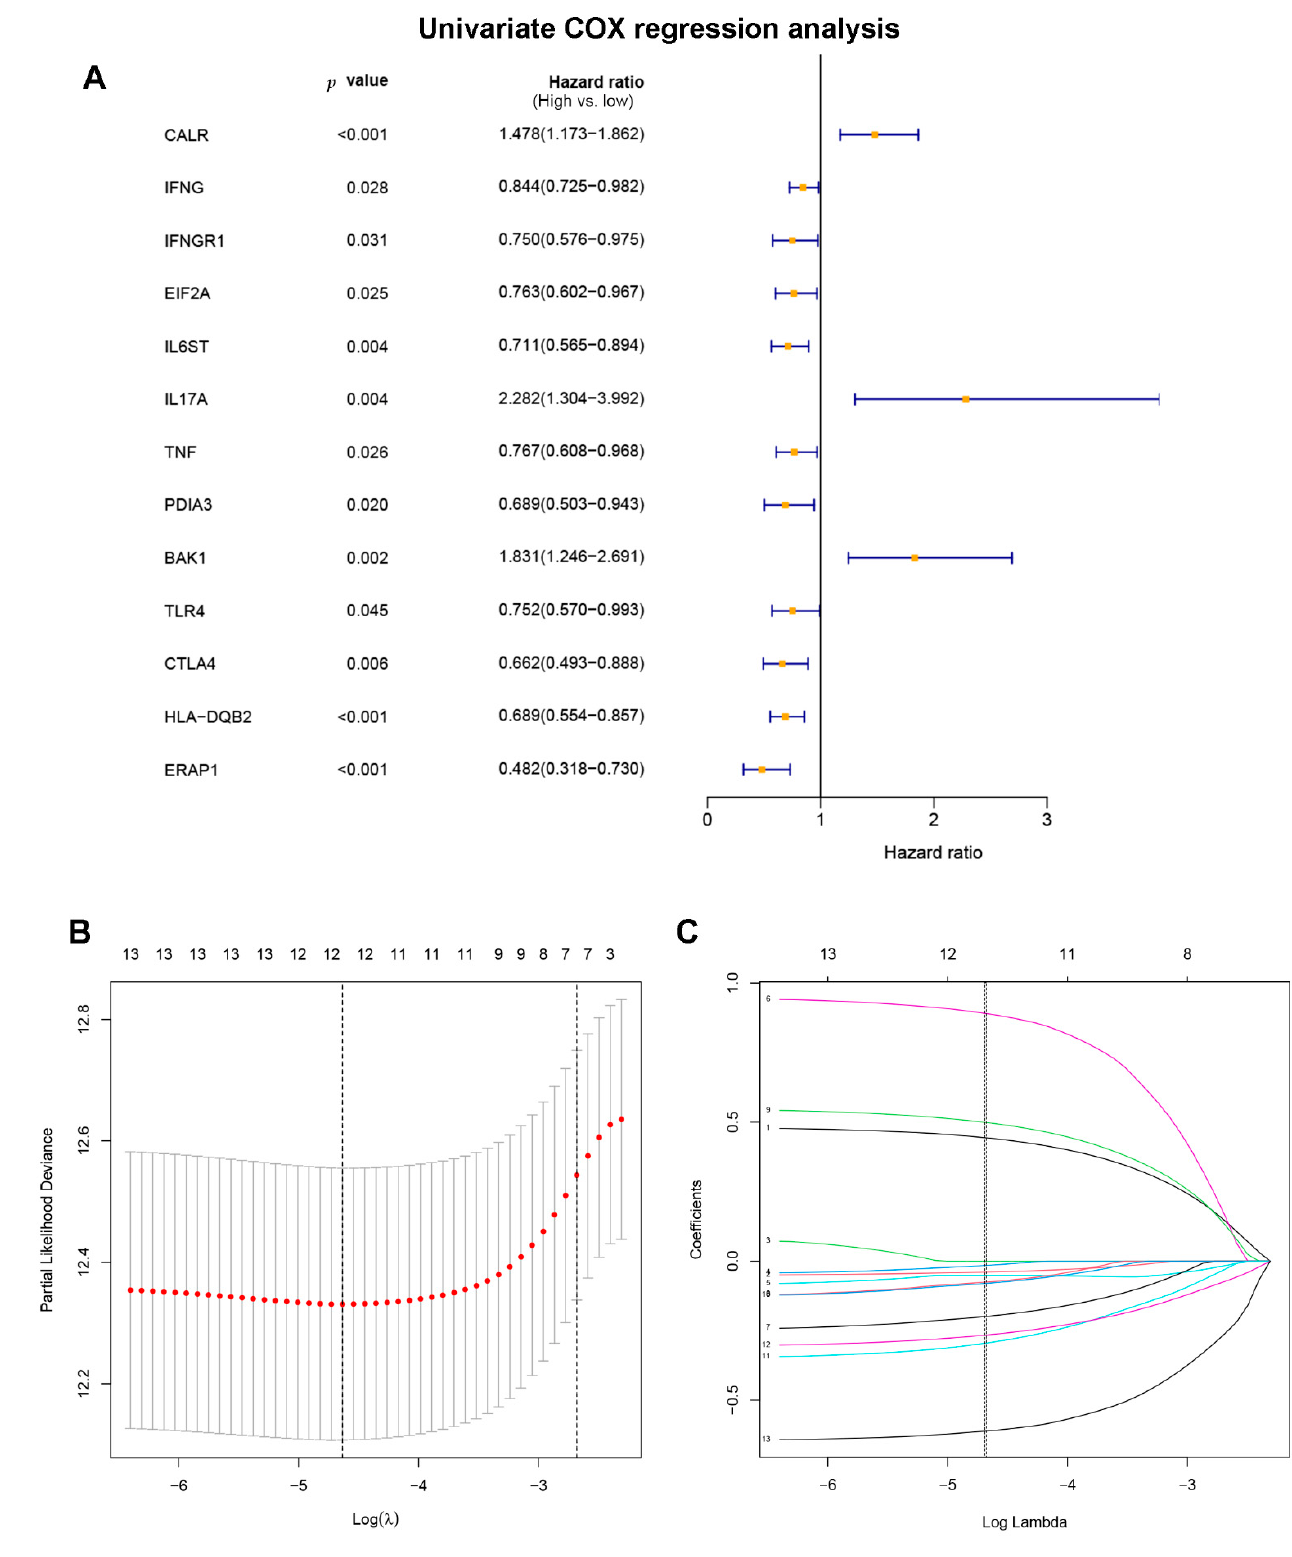
Figure 2. Construction of ICD-related gene signature. ( A ) Identify prognostic immunogenic cell death-related genes through univariate Cox regression analysis. ( B ) The optimal λ was selected, which was drawn with imaginary perpendicular lines. ( C ) LASSO Cox regression analysis revealed twelve immunogenic cell death-related genes.